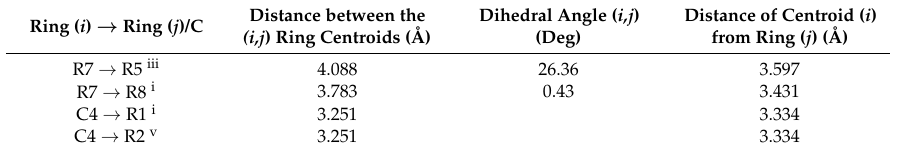
Ring ( i ) → Ring ( j )/C